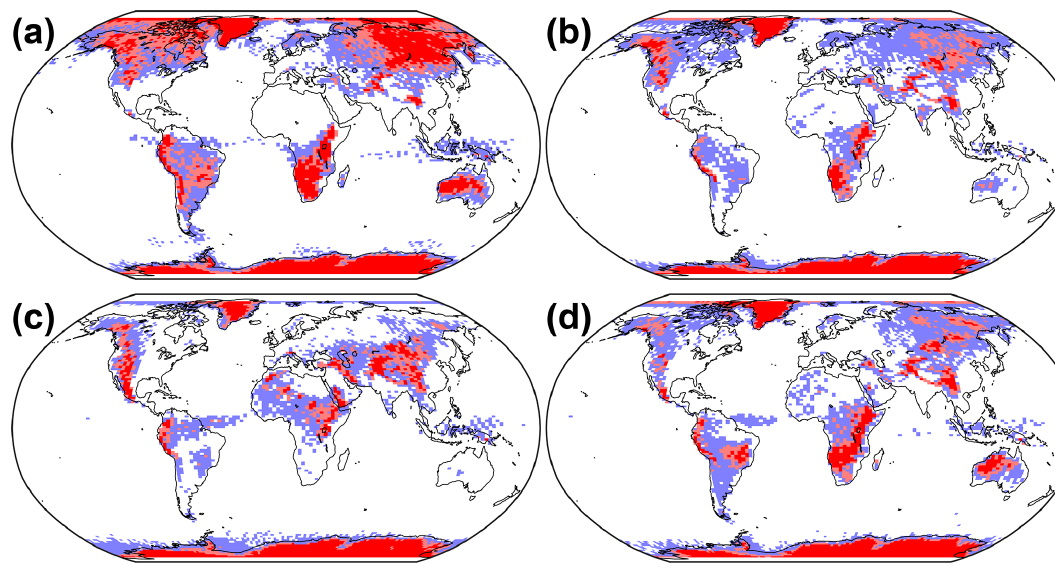
Figure A7. Same as Fig. 9b but for the 3-month periods (a) DJF, (b) MAM, (c) JJA, and (d) SON.